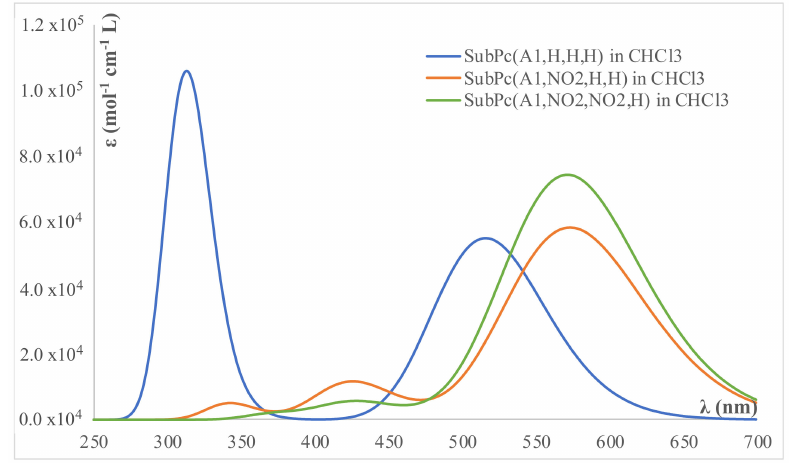
Figure 3. Calculated UV–visible spectra for SubPc(A1,R 1 ,R 2 ,R 3 ), with R 1 = R 2 = R 3 = H; R 1 = NO 2 ,